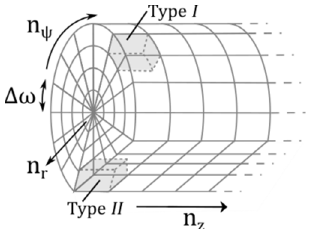
Figure 1. Schematic example of the cell discretization for a semi-cylindrical enclosure resembling a rotary kiln with a bed material approximated as a plane.